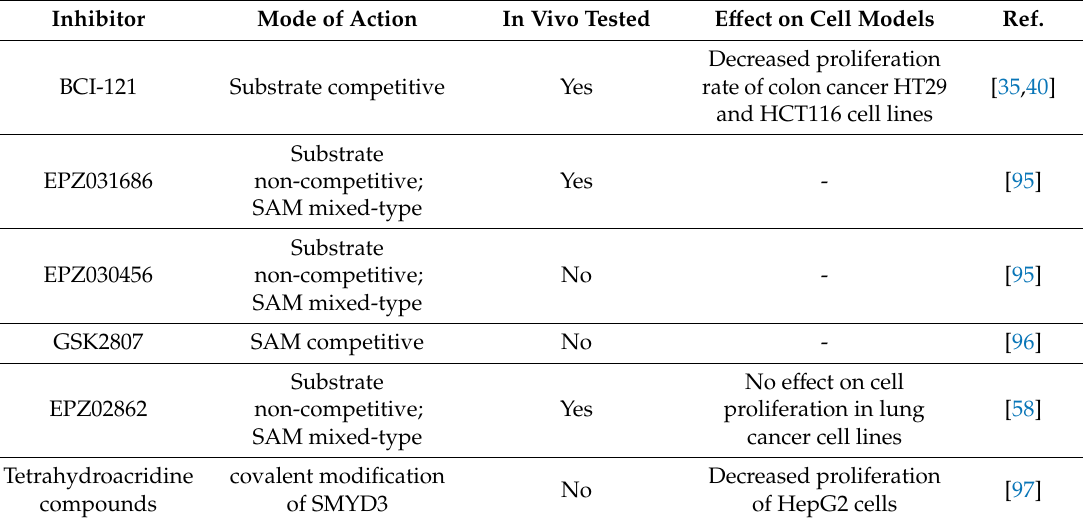
Table 4. Summary of SMYD3